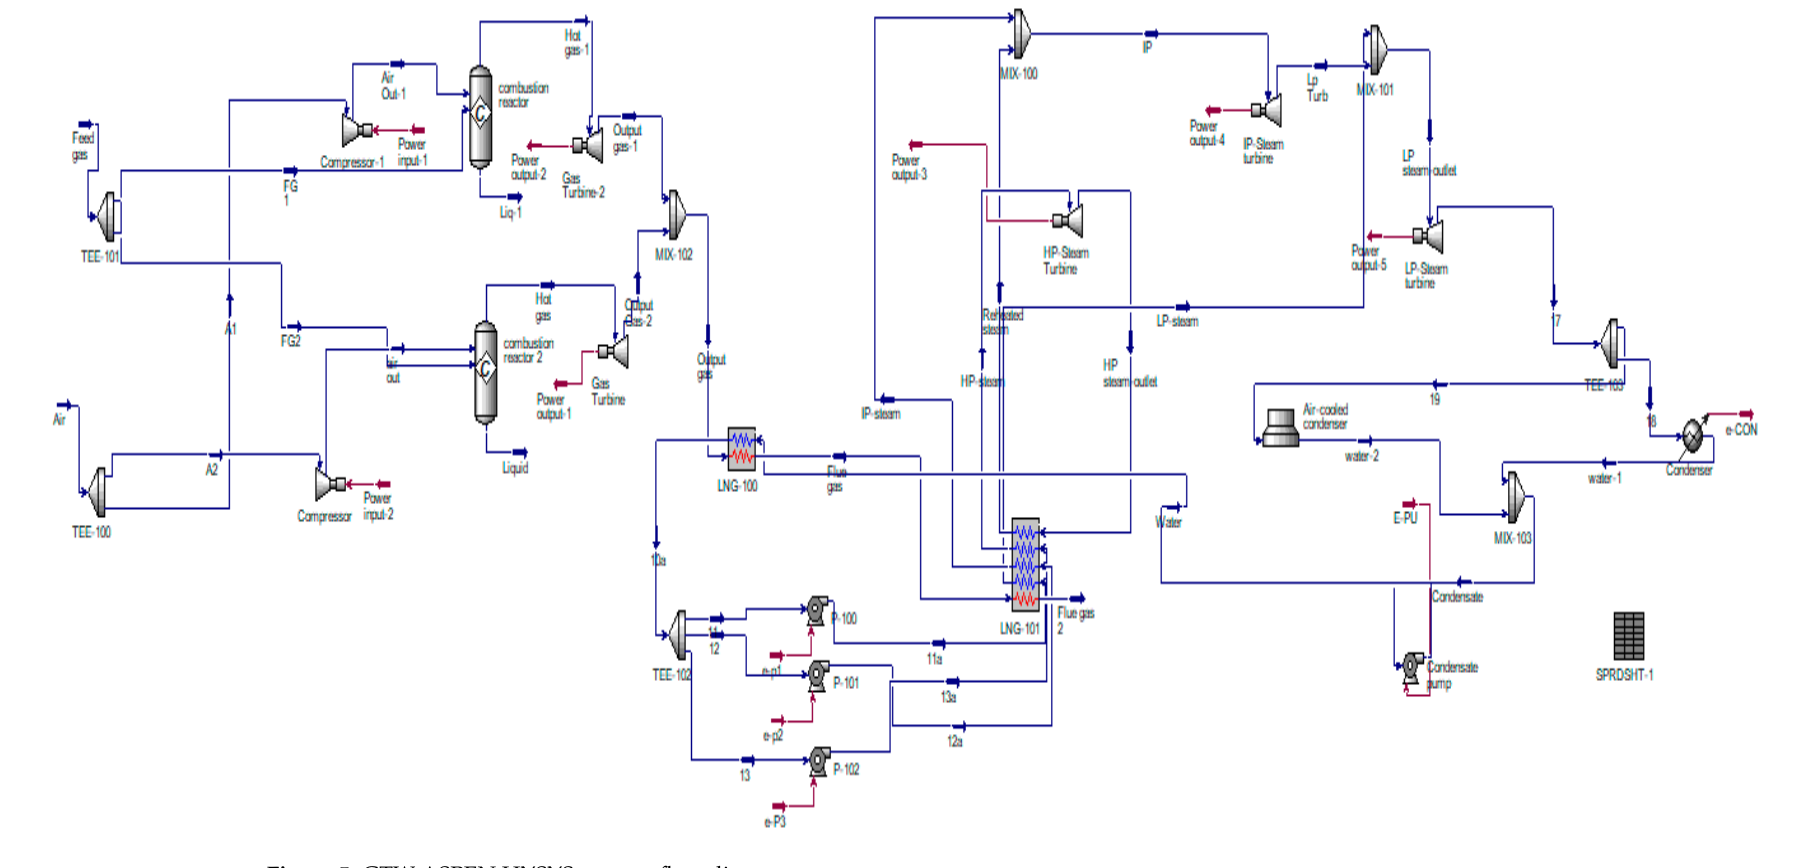
Figure 5. GTW ASPEN HYSYS process flow diagram.